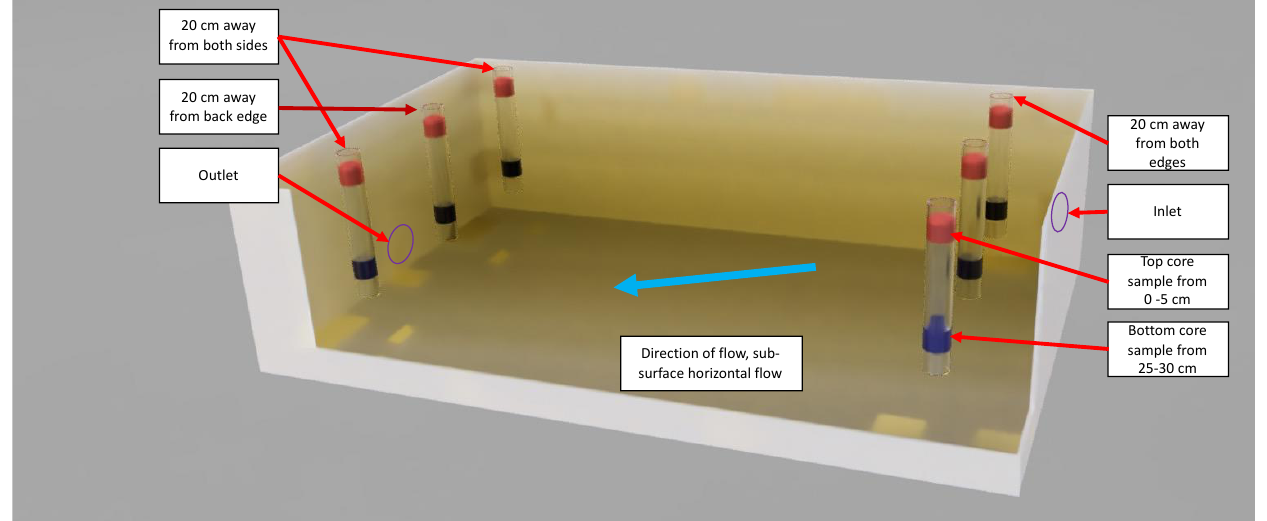
Figure 2. Sample locations of onsite treatment system.